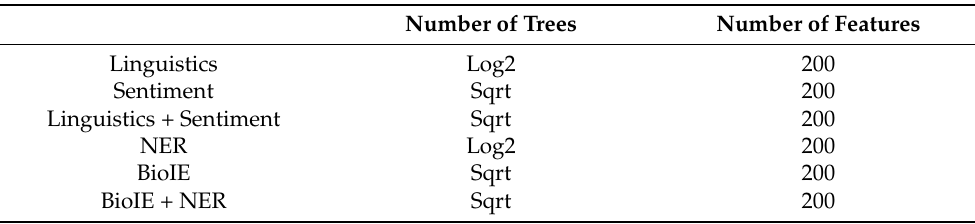
Table 8. Optimal hyperparameter combinations for random forest models trained on different types of features.